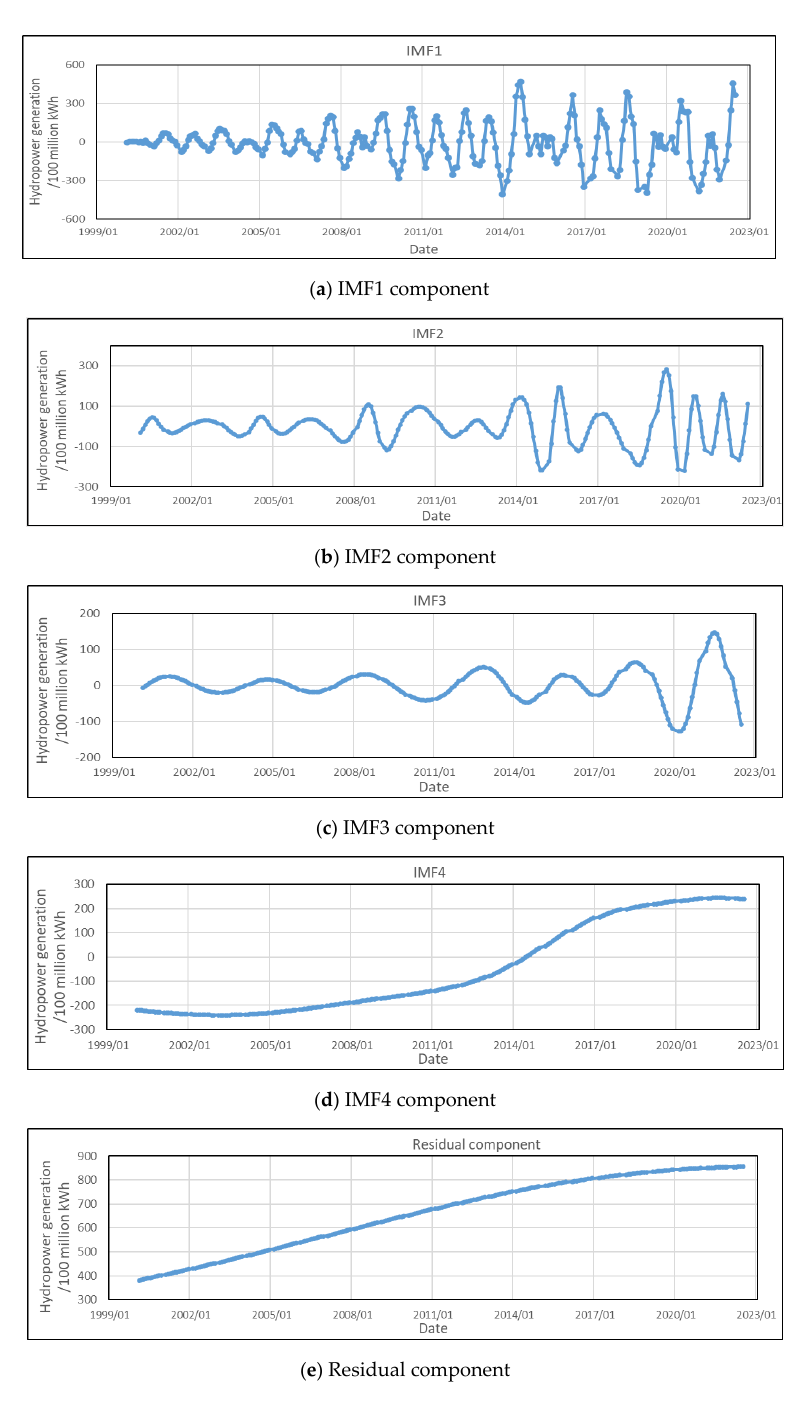
Figure 5. Decomposition results of China’s hydropower generation data.